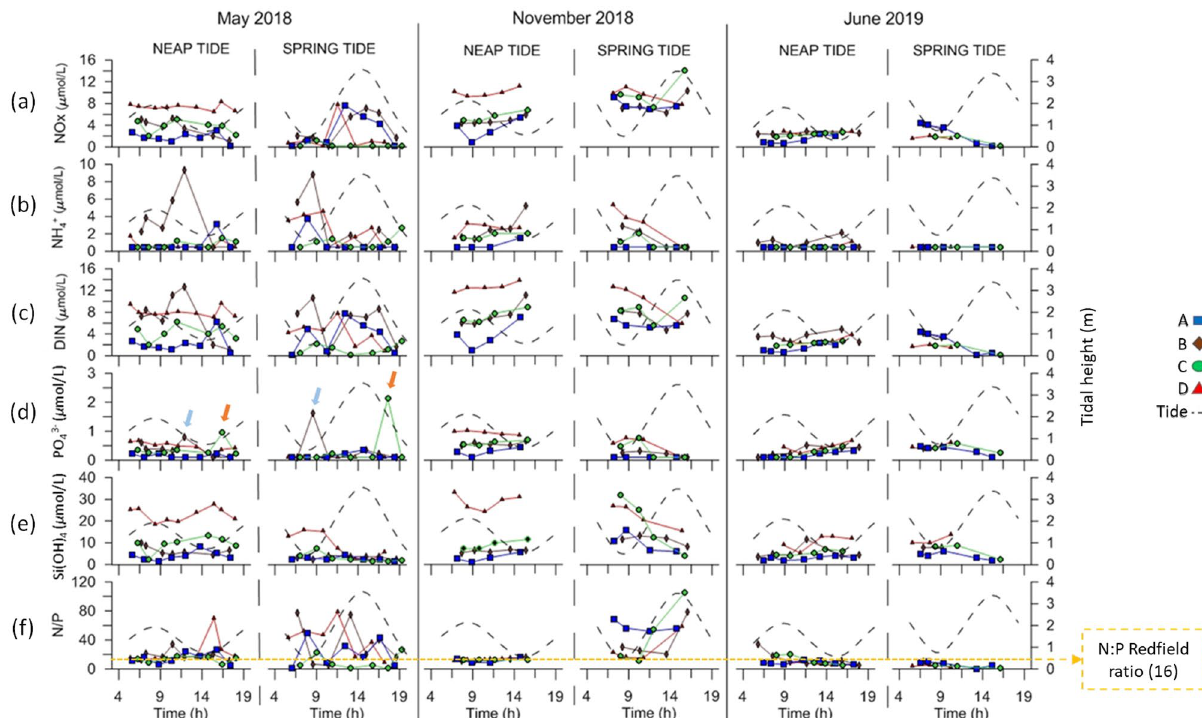
Figure 3. Tidal variability of the total oxidized nitrogen (NO x ), ammonium (NH 4 + ), dissolved inorganic nitrogen (DIN), phosphates (PO 4 3− ), silicate (Si(OH) 4 ) and nitrogen-phosphorus ratio (N/P) observed during the sampling campaigns in neap tide and spring tide conditions. All data were collected at the surface of the water column. The tidal height is represented in grey dashed lines. Yellow dashed line represents the N:P Redfield ratio (16). Blue and orange arrows correspond to unusual higher values of PO 4 3− obtained at station B and C, respectively. Sampling stations are colored as follows: A—blue, B—brown, C—green and D—red. The figure was produced using PRIMER 6 (6.1.16) + PERMANOVA (1.0.6) software from PRIMER-e (https:// www. primer- e.